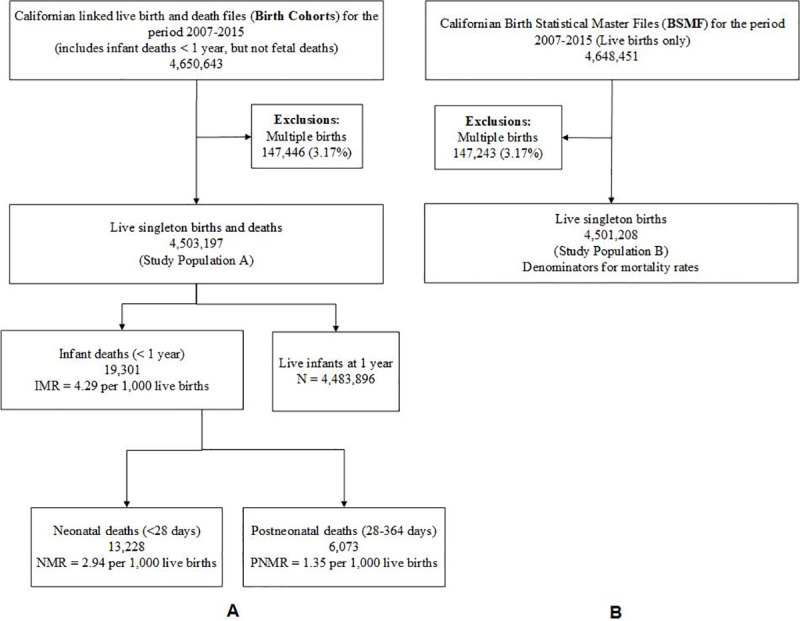
Screening criteria to identify study populations (A) Californian linked birth and infant death files (Birth Cohorts), 2007–2015, and (B) Californian live births from the Birth Statistical Master files (BSBF), 2007–2015, to study infant mortality rate (IMR), neonatal mortality rate (NMR), and postneonatal mortality rate (PNMR) per 1,000 live births for singleton births only in California for the period 2007–2015.